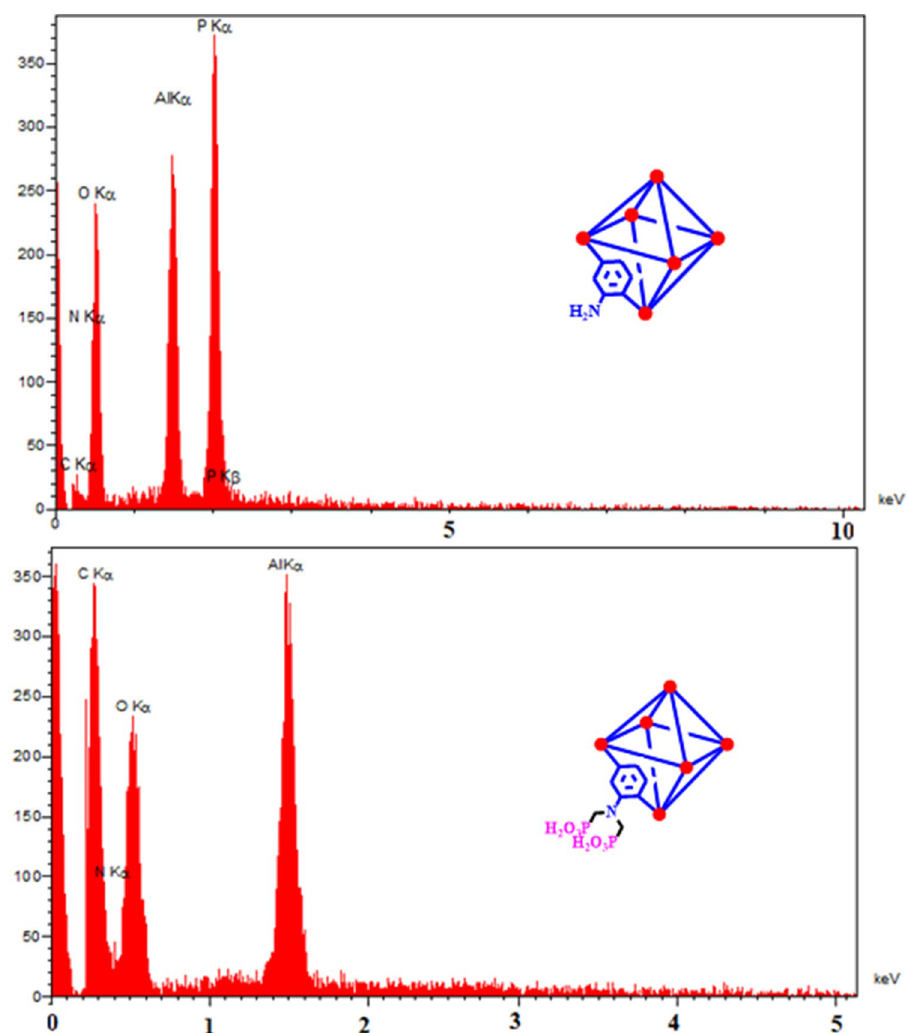
Figure 9. EDX analysis and elemental mapping of electro-synthesized MIL-53(Al)-NH 2 and MIL-53(Al)- N(CH